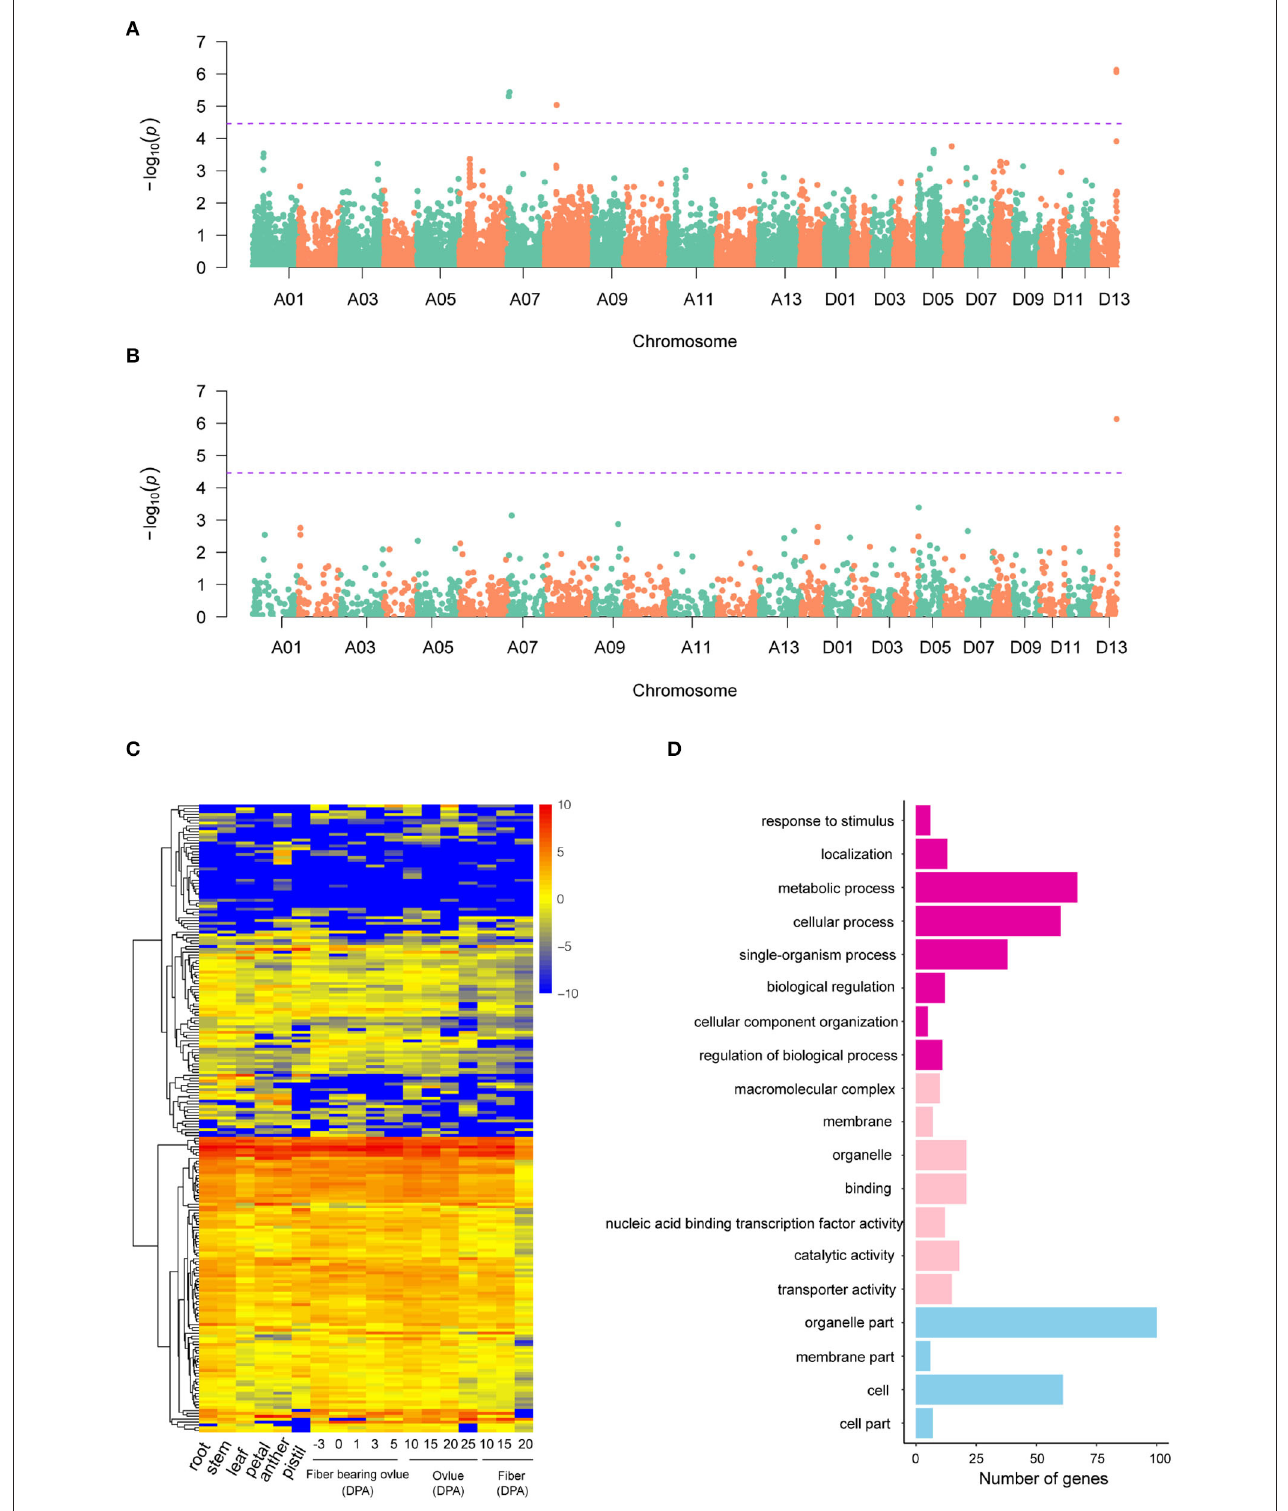
FIGURE 3 | GWAS results of SNP and InDel markers and candidate gene analysis. (A,B) Manhattan plots of BW-BLUP for SNPs and InDels, respectively; significant BW-associated markers are distinguished by purple lines. (C) Heatmap of candidate gene expression patterns in 18 cotton tissues. (D) GO analysis of candidate genes associated with boll weight. The chart of purple, pink, and blue represented biological process, molecular function, and cellular component, respectively.